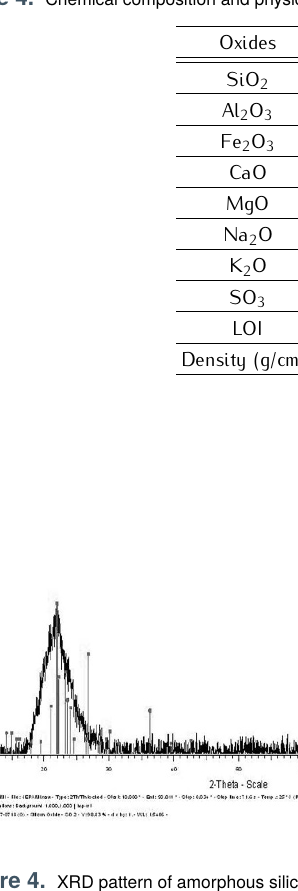
Figure 6. Compressive strength of the OPC and rice husk ash con- crete.